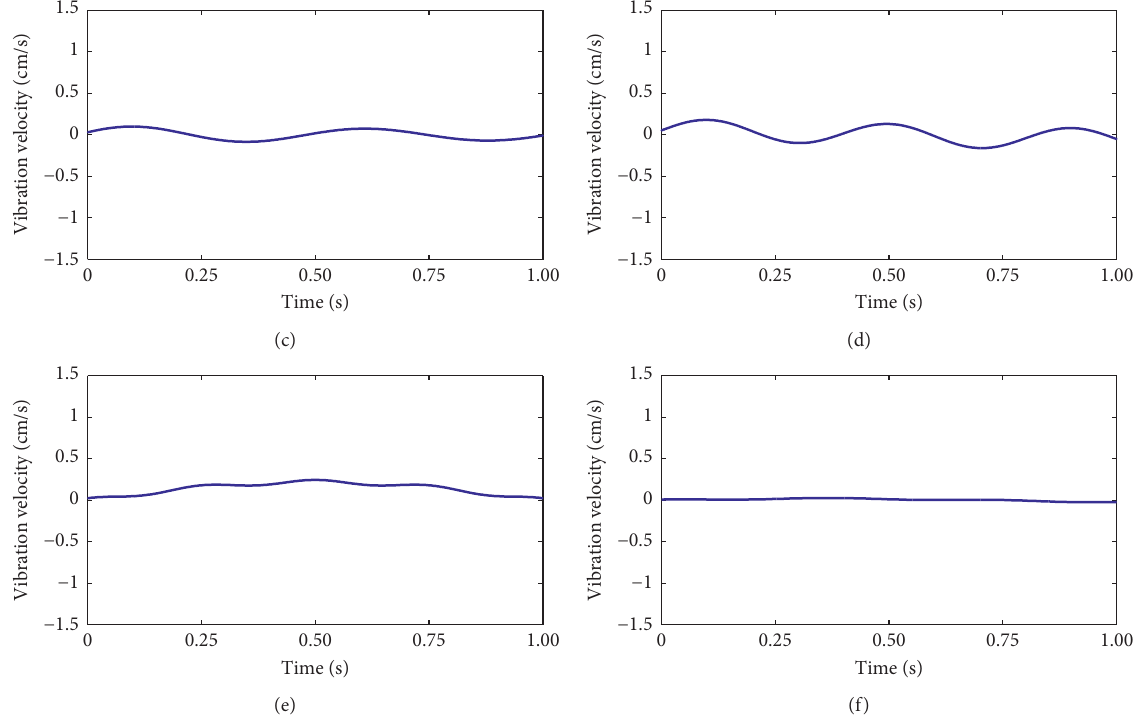
Figure 2: Original signal and low-frequency noise. (a) Original signal. (b) Low-frequency 1. (c) Low-frequency 2. (d) Low-frequency 3. (e) Low-frequency 4. (f) Low-frequency